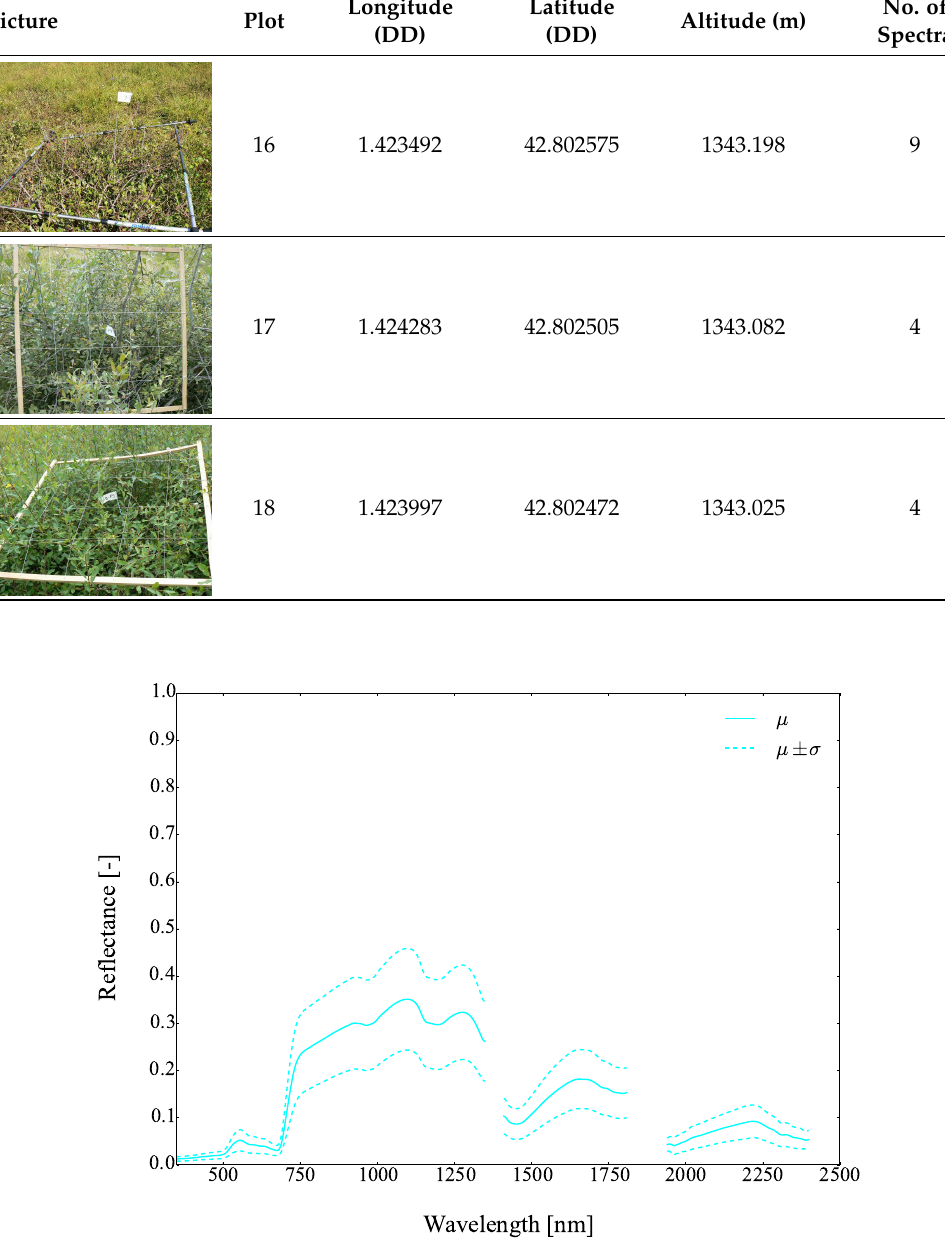
Table A9. Pictures, plots, geographic coordinates and number of spectra of Salix sp. (SALI). Picture